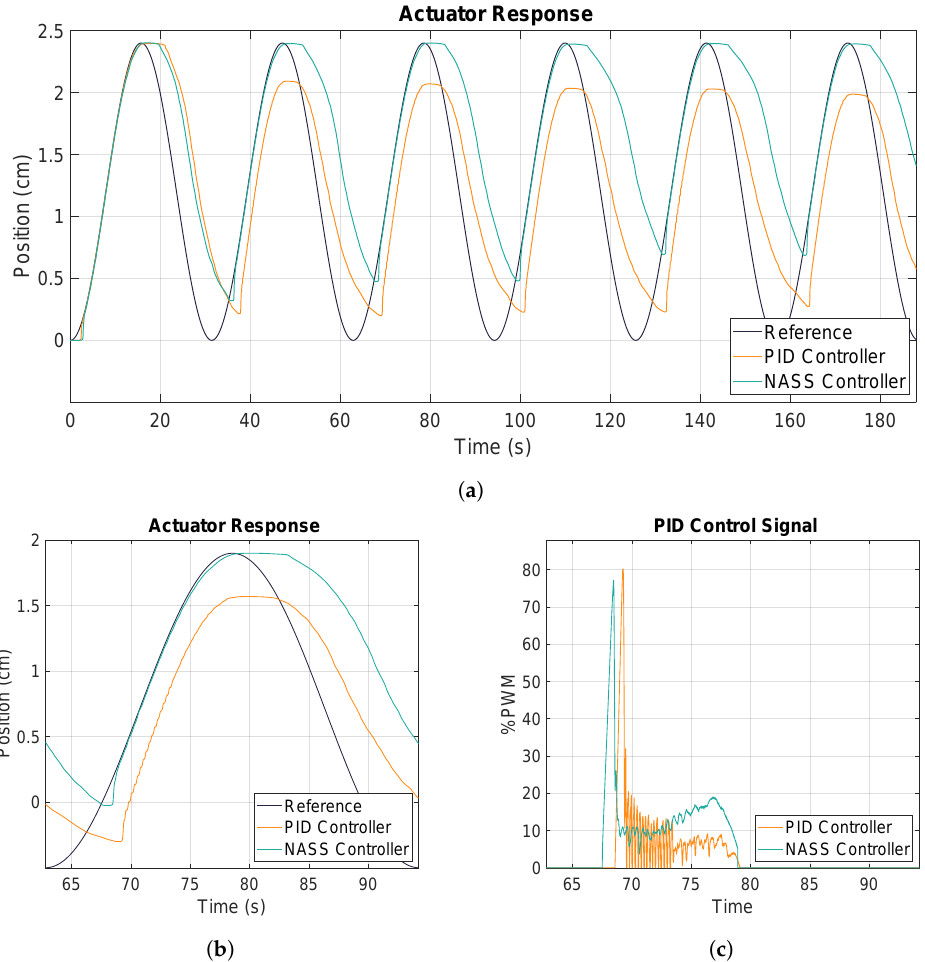
Figure 11. Comparison of the PID and NASS controllers for a frequency of 0.2 rad/s and a load of 2.00 kg. ( a ) General position comparison. ( b ) Detailed position comparison. ( c ) Detailed control signal